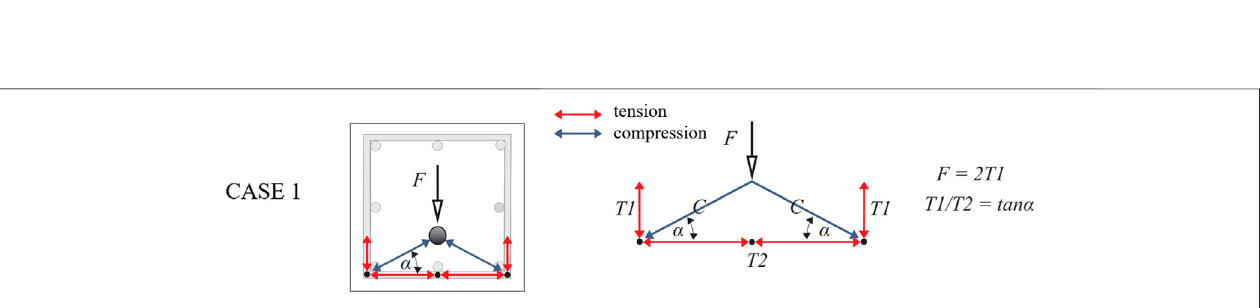
FIGURE 4 | Strut and tie model for a connection with a single eccentric dowel and perimeter hoops [adopted from Zoubek et al. (2015)]